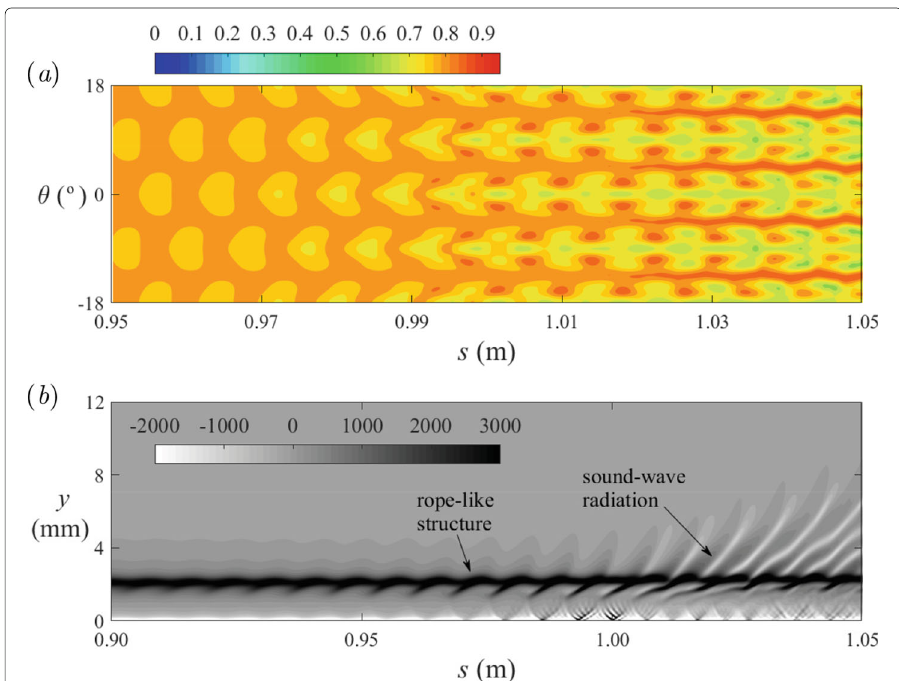
Fig. 9 Contours of the instantaneous flow: ( a ) the streamwise velocity u / U ∞ at y = 1.4mm in the s − θ plane and ( b ) the wall-normal gradient of the density ∂ρ/(ρ ∞ ∂ y ) in the s − y